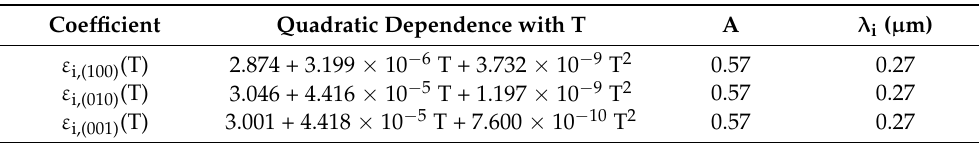
Table 1. T-dependent dispersion relations derived from ellipsometry measurements for (100), (010) and (001)